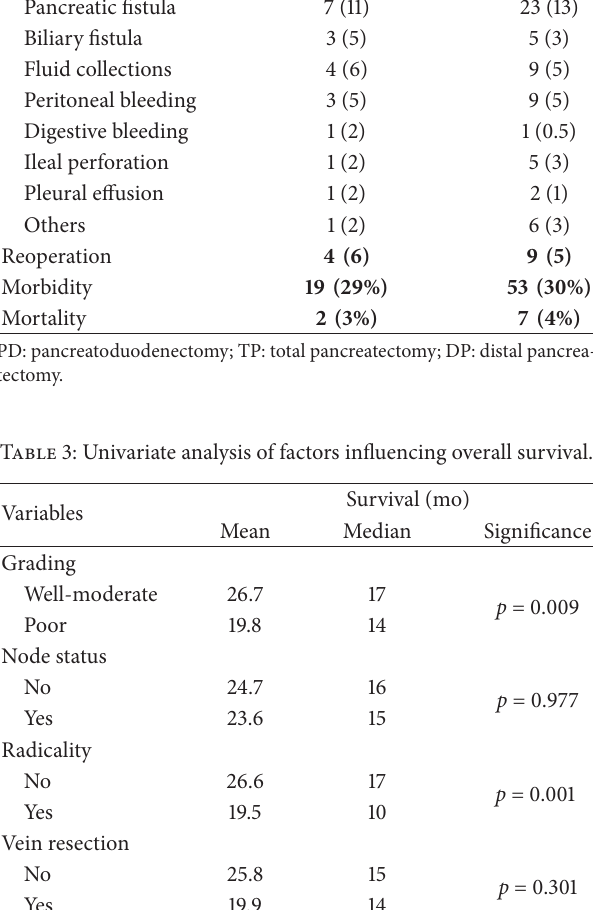
Mean and median overall survival time were 24 and 15 months, respectively. Mean survival time was 26 months for patients without vascular resection versus 20 months for